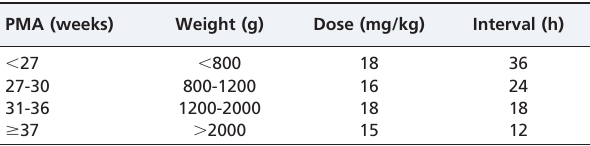
Table 3 - Initial vancomycin dosage guidelines in neonates based on postmenstrual age (PMA) or weight, developed by McDougal et al.